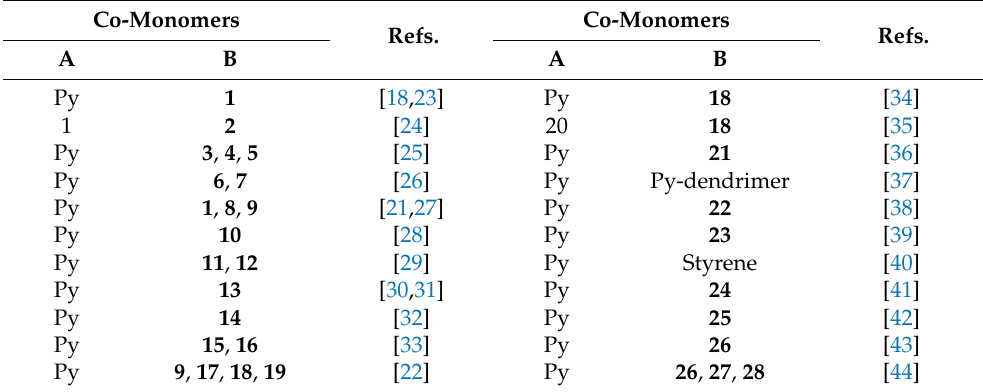
Table 1. Summary of pyrrole-based co-monomer combinations used for copolymerisation.